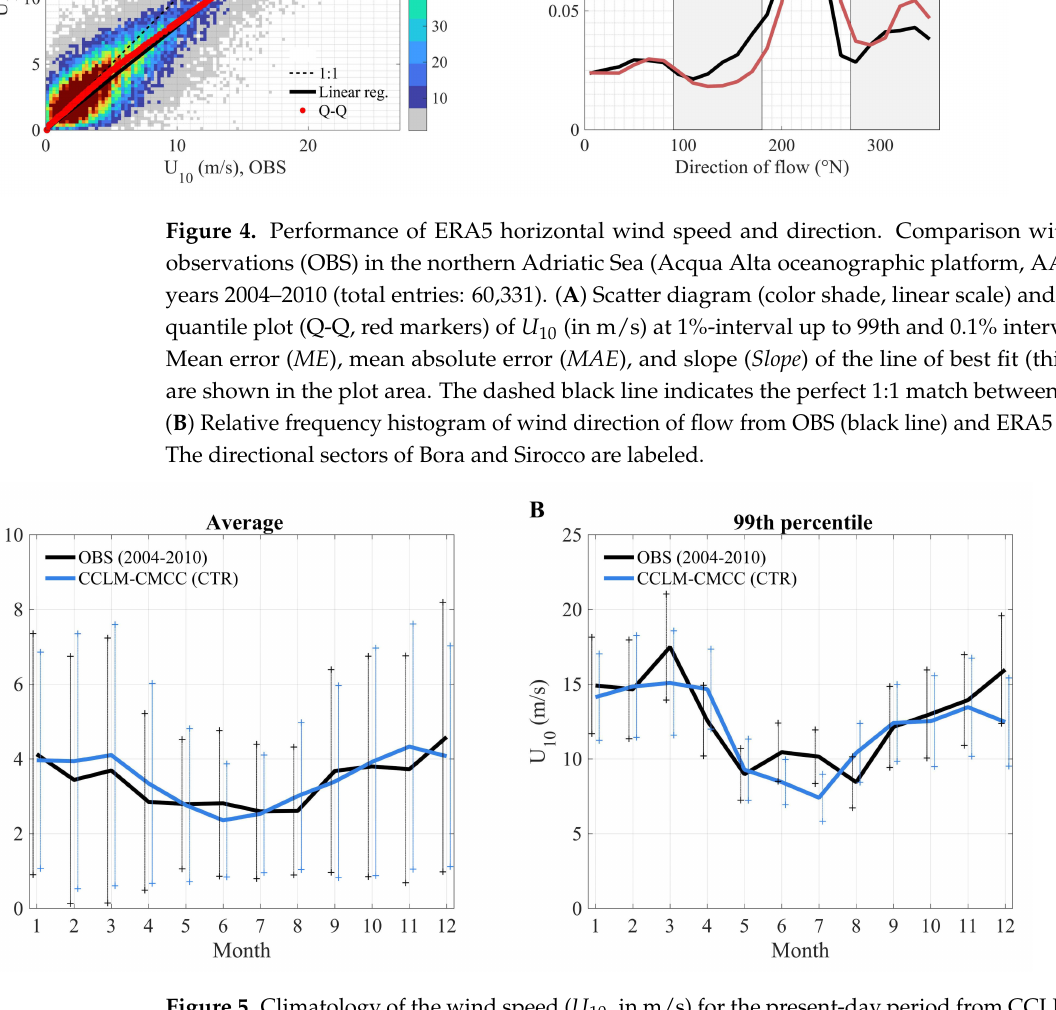
Figure 5. Climatology of the wind speed ( U 10 , in m/s) for the present-day period from CCLM-CMCC data (CTR run, blue line) and in situ observations (OBS, black line) in the northern Adriatic Sea (Acqua Alta oceanographic platform, AA). Climatological mean value (solid line) and year-to-year variability (denoted by the standard deviation about the mean; cross markers) of the monthly average ( A ) and monthly 99th percentile ( B ). For clarity, the vertical scale changes between the two